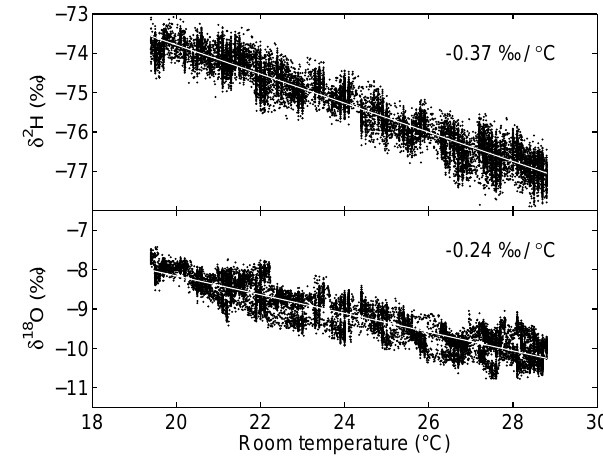
Fig. 7. Sensitivity to room temperature variations for δ 2 H (top) and δ 18 O (bottom). The dots are 10s averaged data and the ordi- nary least squares fits yield slopes of − 0.37‰ / ◦ C ( R 2 = 0 . 92) and − 0.24‰ / ◦ C ( R 2 = 0 . 82) for δ 2 H and δ 18 O, respectively (white